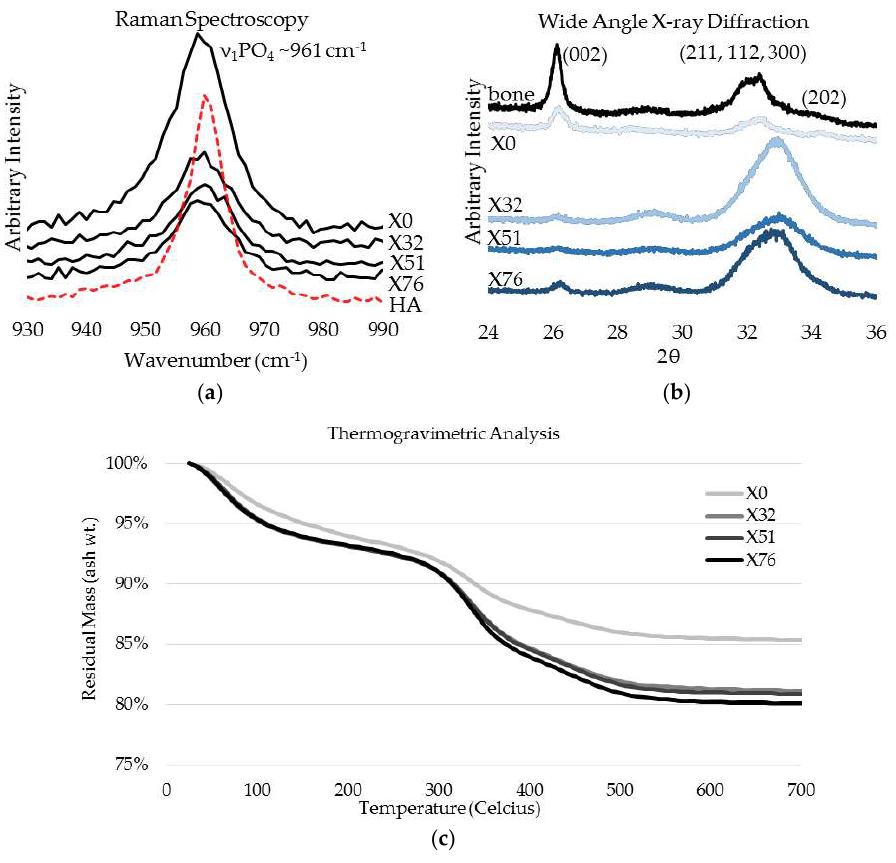
Figure 2. Characterization of crosslinked, polymer-induced liquid-precursor (PILP) mineralized LCC scaffolds. ( a ) Raman spectra from the four experimental groups (black) as compared with that of commercial HA (red dashed line) which has a sharp symmetric peak centered around 961 cm − 1 due to the ν 1 PO 4 vibrational mode of crystalline hydroxyapatite; ( b ) WAXS spectra of the four experimental groups compared to a bovine bone; and, ( c ) thermogravimetric analysis (TGA) residual ash weights indicate the scaffolds were highly mineralized and may have contained over 80 wt. % inorganic material.